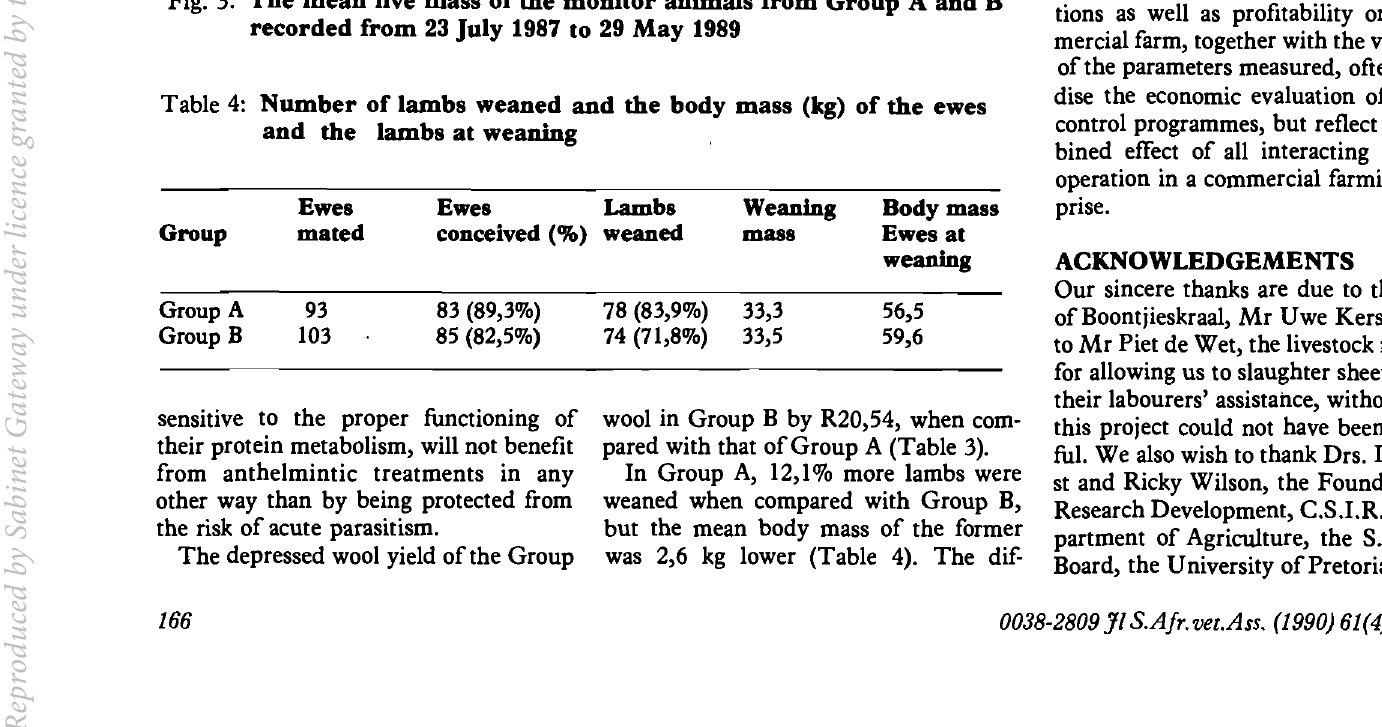
Fig. 3: The mean live mass of the monitor animals from Group A and B recorded from 23 July 1987 to 29 May 1989 Table 4: Number of lambs weaned and the body mass (kg) of the ewes and the lambs at weaning Ewes